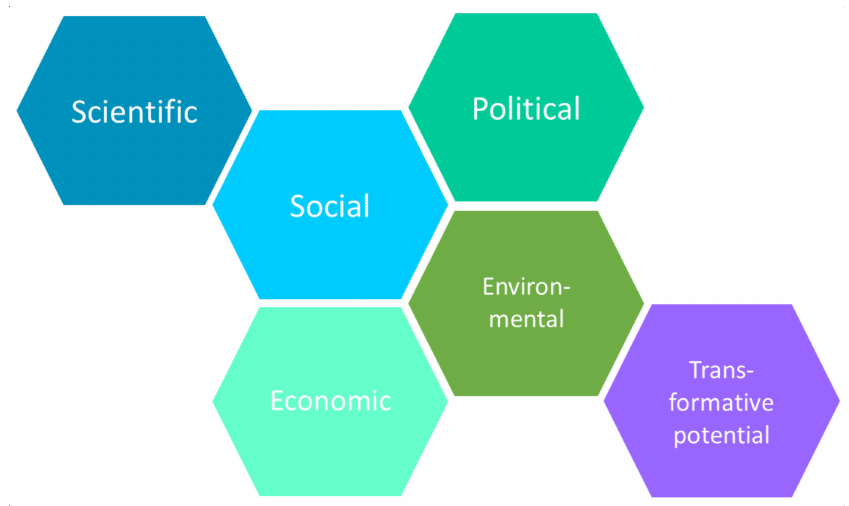
Figure 1. Framework for assessing impact and transformative potential. Each impact area is articulated in several dimensions, for a total of 24 dimensions (Figure 2).